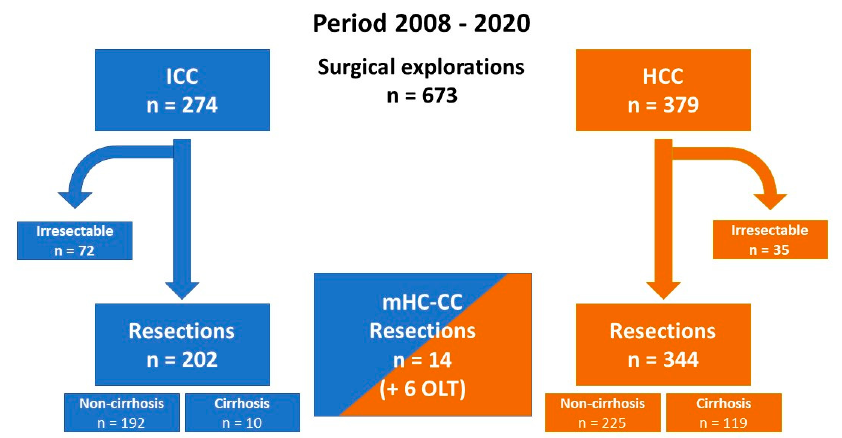
Figure 1. Flow chart of explorations and resection for intrahepatic cholangiocarcinoma (ICC), hepatocellular carcinoma (HCC), and mixed hepatocellular cholangiocarcinoma (mHC-CC). OLT = orthotopic liver transplantation.